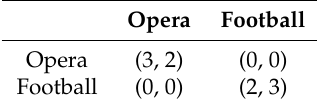
Figure 1. Battle of the Sexes